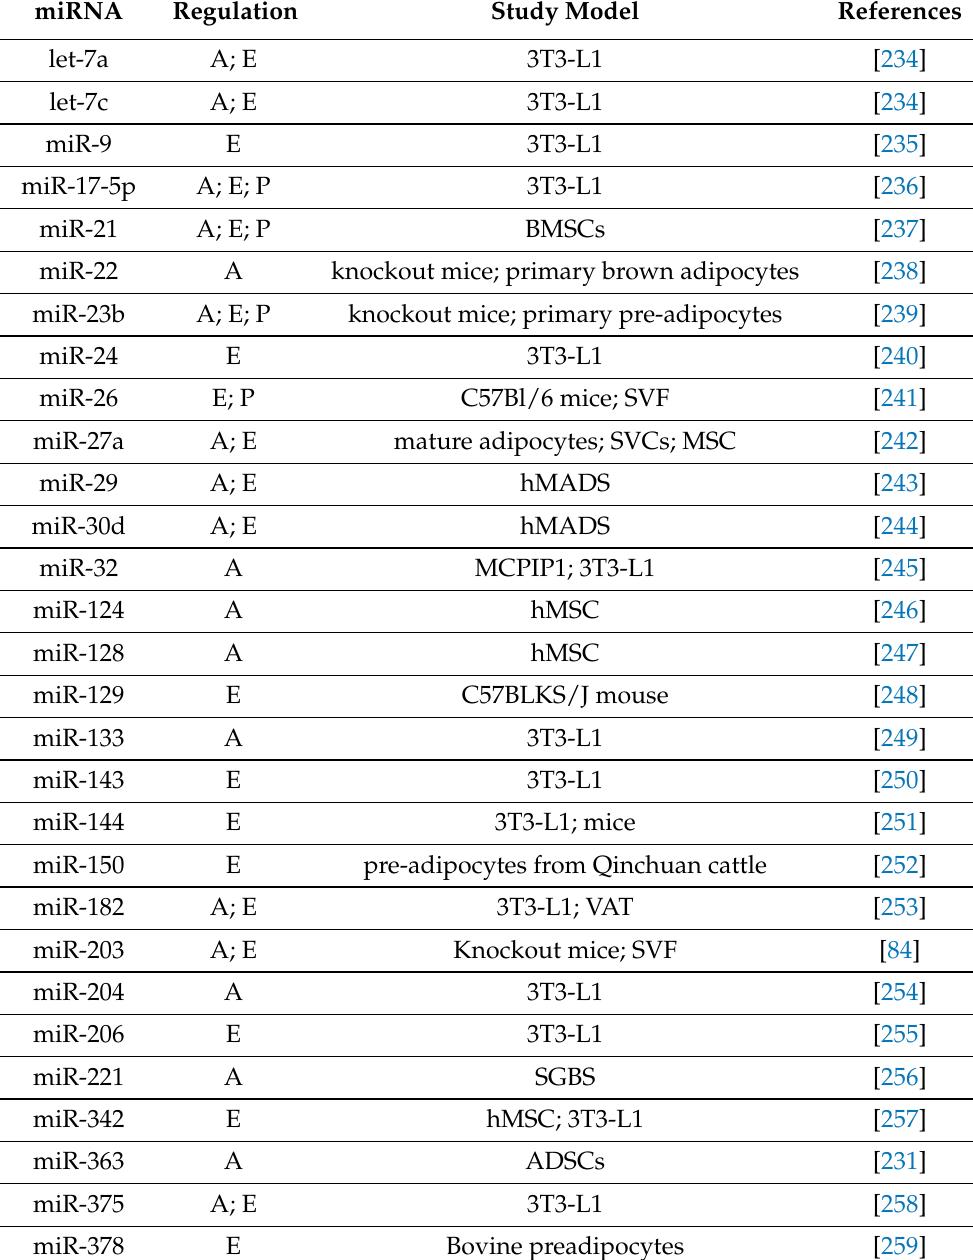
Abbreviations: A, androgens; E, estrogens; P, progesterone. Table 1 is based on [34–37] (Regulation) and references given in the table (miRNA, Metabolic